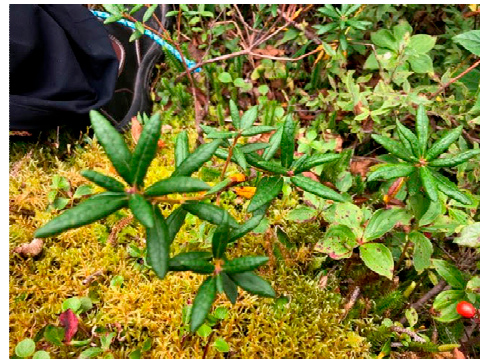
Figure 4. Sitting in relationship, with swamp tea and moss.